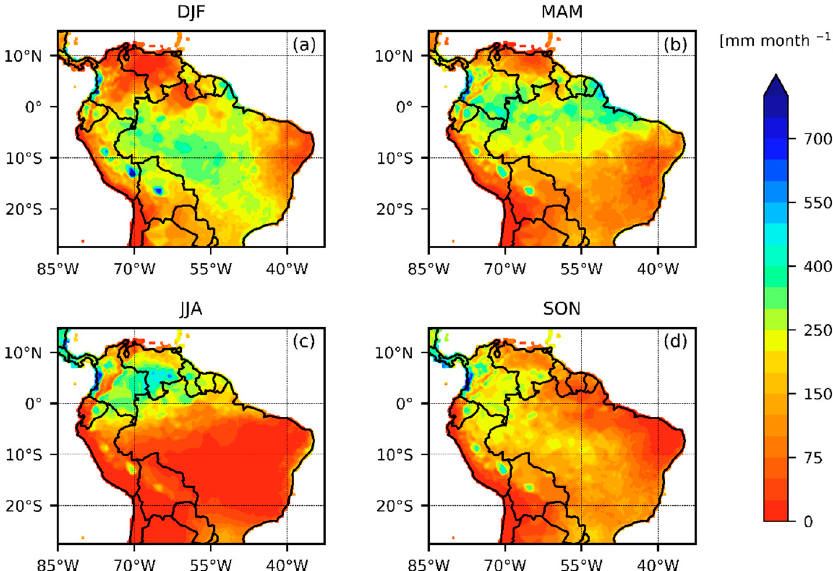
Figure 1. Monthly average precipitation within each season for the 1931–2016 period: ( a ) December– January–February (DJF); ( b ) March–April–May (MAM); ( c ) June–July–August (JJA); and ( d ) September– October–November (SON). Data from the Global Precipitation Climatology Centre (GPCC) Full Data Monthly Product Version 2018 at 0.25° resolution.